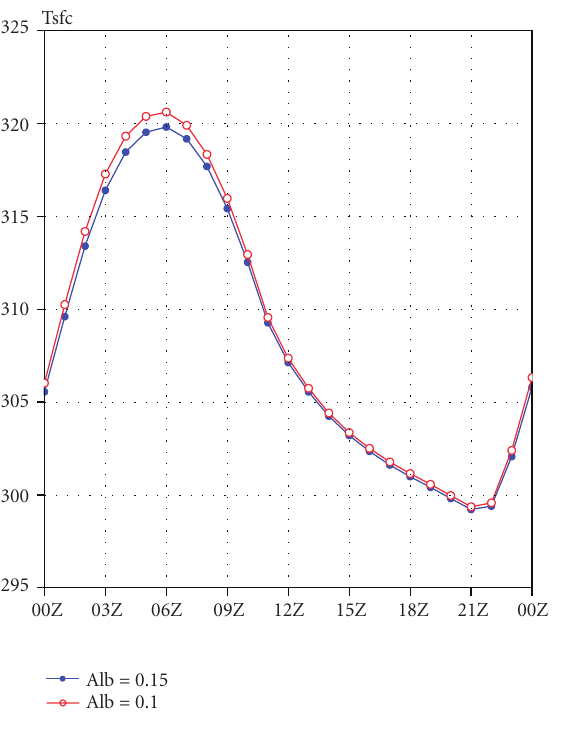
Figure 11: Sensitivity study for surface albedo e ff ect on surface skin temperature. Alb = 0.15 is the high albedo case when surface albedo is set as 0.15, and alb = 0.10 is the low albedo case when the surface albedo is set as 0.10. The experiment area is over Beijing (39.7– 40.1 ◦ N, 116.1–116.7 ◦ E). The unit of the y -axis is Kelvin